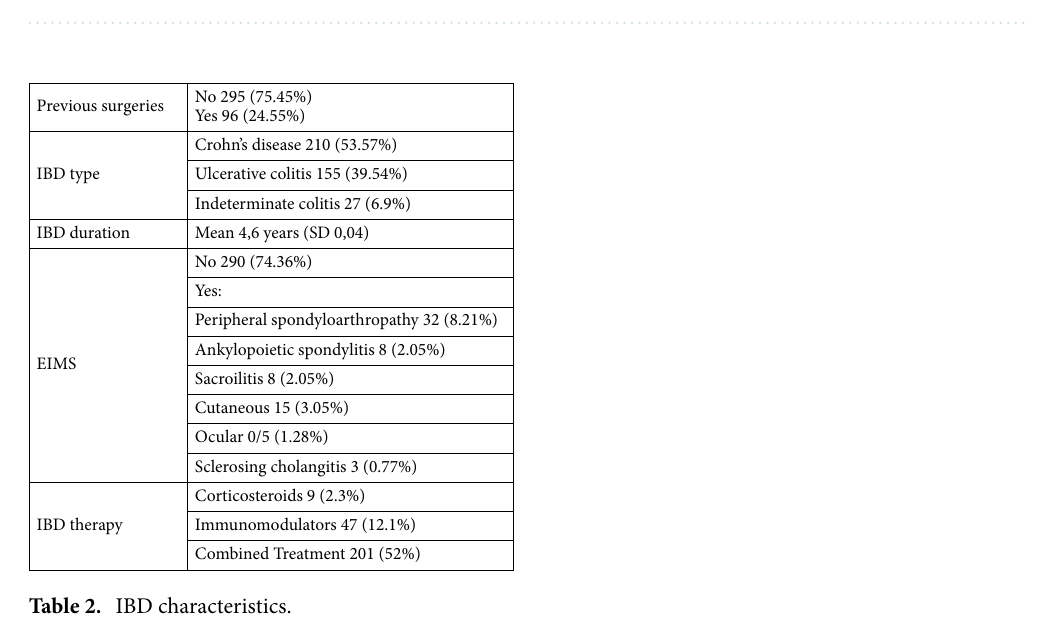
Table 1. Baseline characteristics.